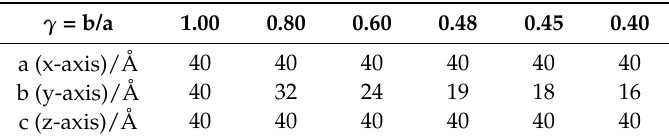
Table 1. Parameters of abrasive particle with different semi-axes a, b and c along x-, y-, and z-directions, respectively.